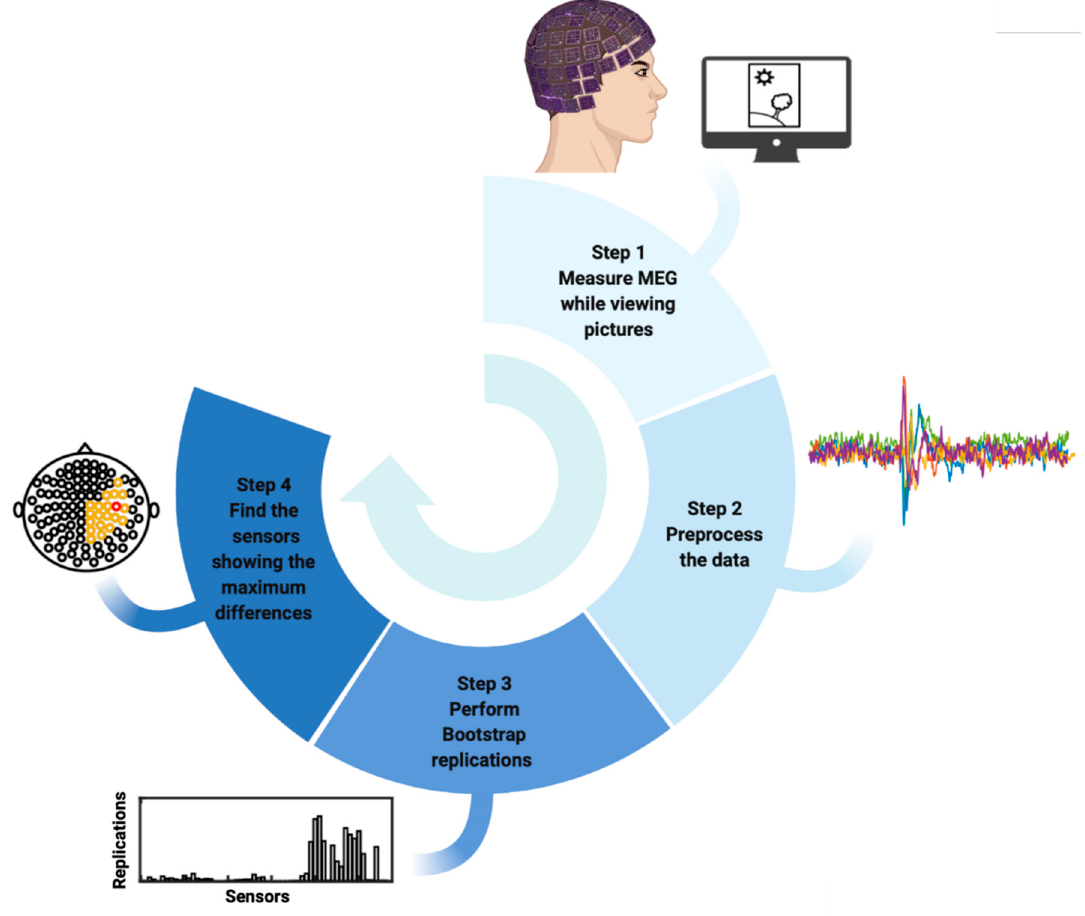
Figure 1. Workflow of the proposed algorithm to find the MEG sensors showing greater differences in human brain response to high-arousing emotional stimuli compared to neutral stimuli.